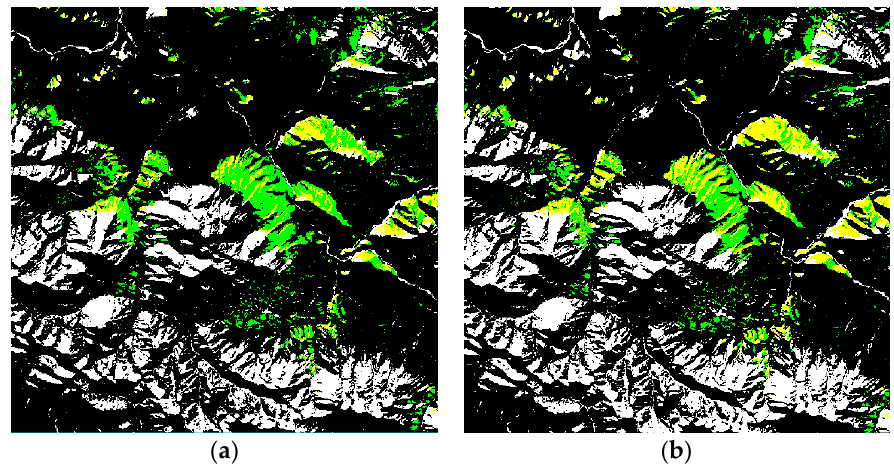
Figure 8. Snow extraction result with NDSI both in forested area and in non-forested area. ( a ) The NDSI threshold value is 0.4; ( b ) the NDSI threshold value is 0.3.